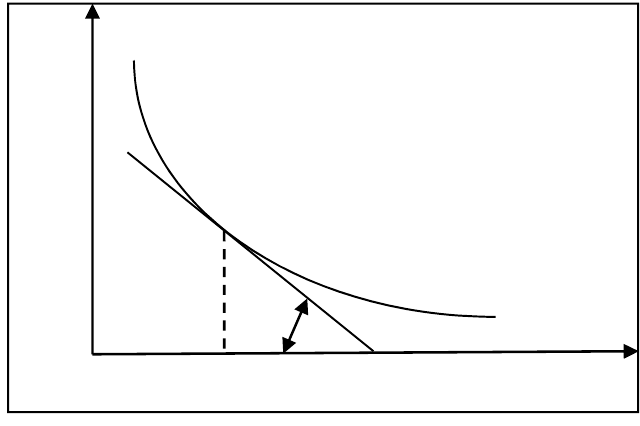
Figure 4. Definition of the free-running temperature of slag.